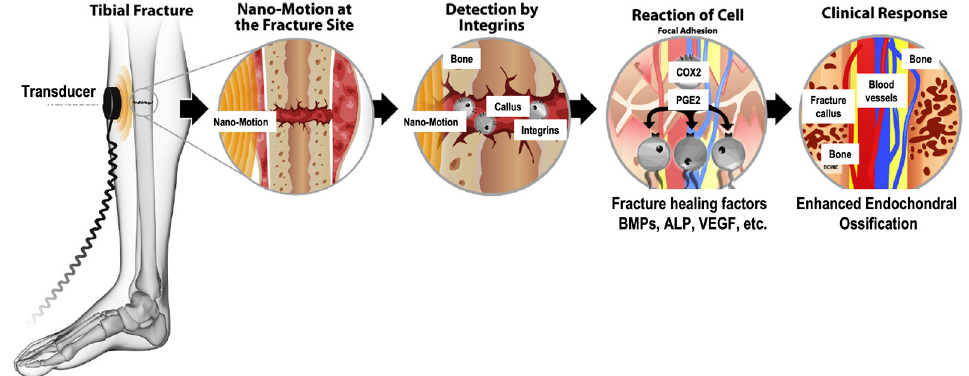
Figure 2. The mechanism of LIPUS on bone tissue repair. The LIPUS waves from the transducer induce forces that activate integrins located in the cell membrane. The activation of integrins leads to the formation of focal adhesions, the phosphorylation of FAK, and the activation of the integrin/phosphatidylinositol 3-OH kinase/Akt pathway. This pathway leads to the formation of COX-2 and PGE2, which are critical for bone formation and fracture healing. Modified from the open access article by Harrison et al. [38]. Copyright 2016, Elsevier Ltd. Table 1. Effects of Cell Type Specific Gene Deletions on the Response of Cells to Mechanical Loading.